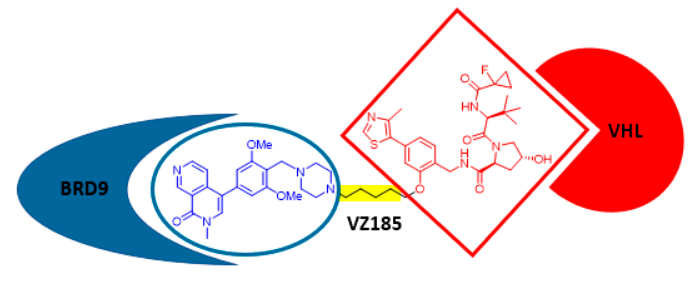
Figure 3. Chemical structure of